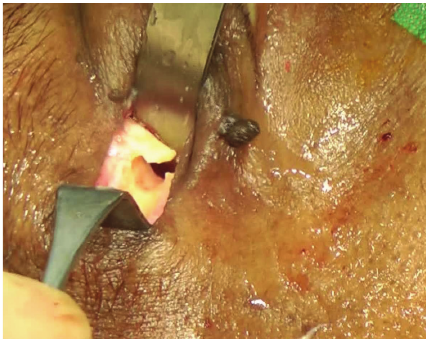
Figure 5: The periost layer was elevated exposing the bone at the sutura frontozygomatica. At this point an L-shaped canal was drilled, providing flexible stability and optimizing angulation for the cable entering the orbit.